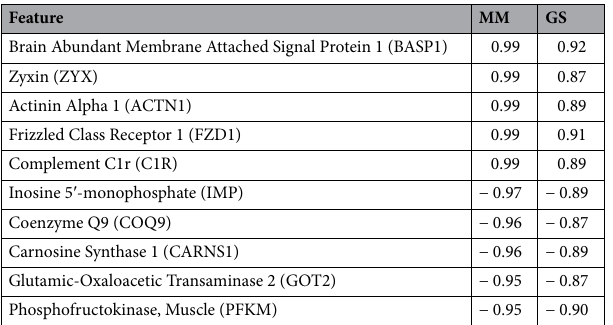
Table 2. Module membership and gene significance of the top 10 hub features in lightyellow module of weighted gene co-expression network analysis in wooden breast myopathy (WB) muscle samples. MM module membership, GS gene significance.